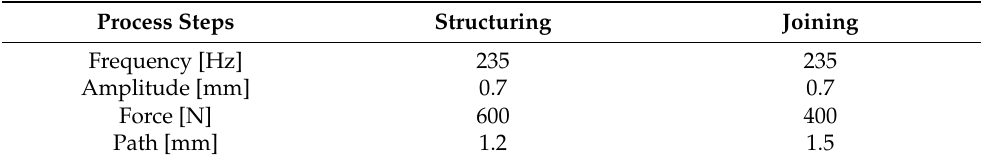
Figure 2. Form-fit multi-material butt joint using pin-like structures [14]. Figure 2. Form ‐ fit multi ‐ material butt joint using pin ‐ like structures [14]. Table 2. Used process parameters. Table 2. Used process